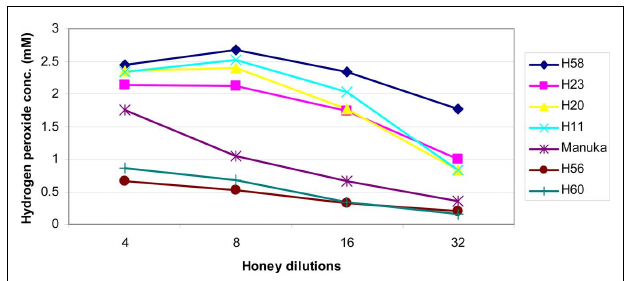
FIGURE 1 | Effect of honey dilutions on the production of hydrogen peroxide. Honeys of buckwheat origin, H58 and H23, together with sweet clover (H20), and wildflower/clover (H11) produced distinctively higher amounts of H 2 O 2 than Manuka (M2) or honey blends (H56 and H60).The H 2 O 2 content was measured in twofold serially diluted honeys, the x axis represents a log2 values.